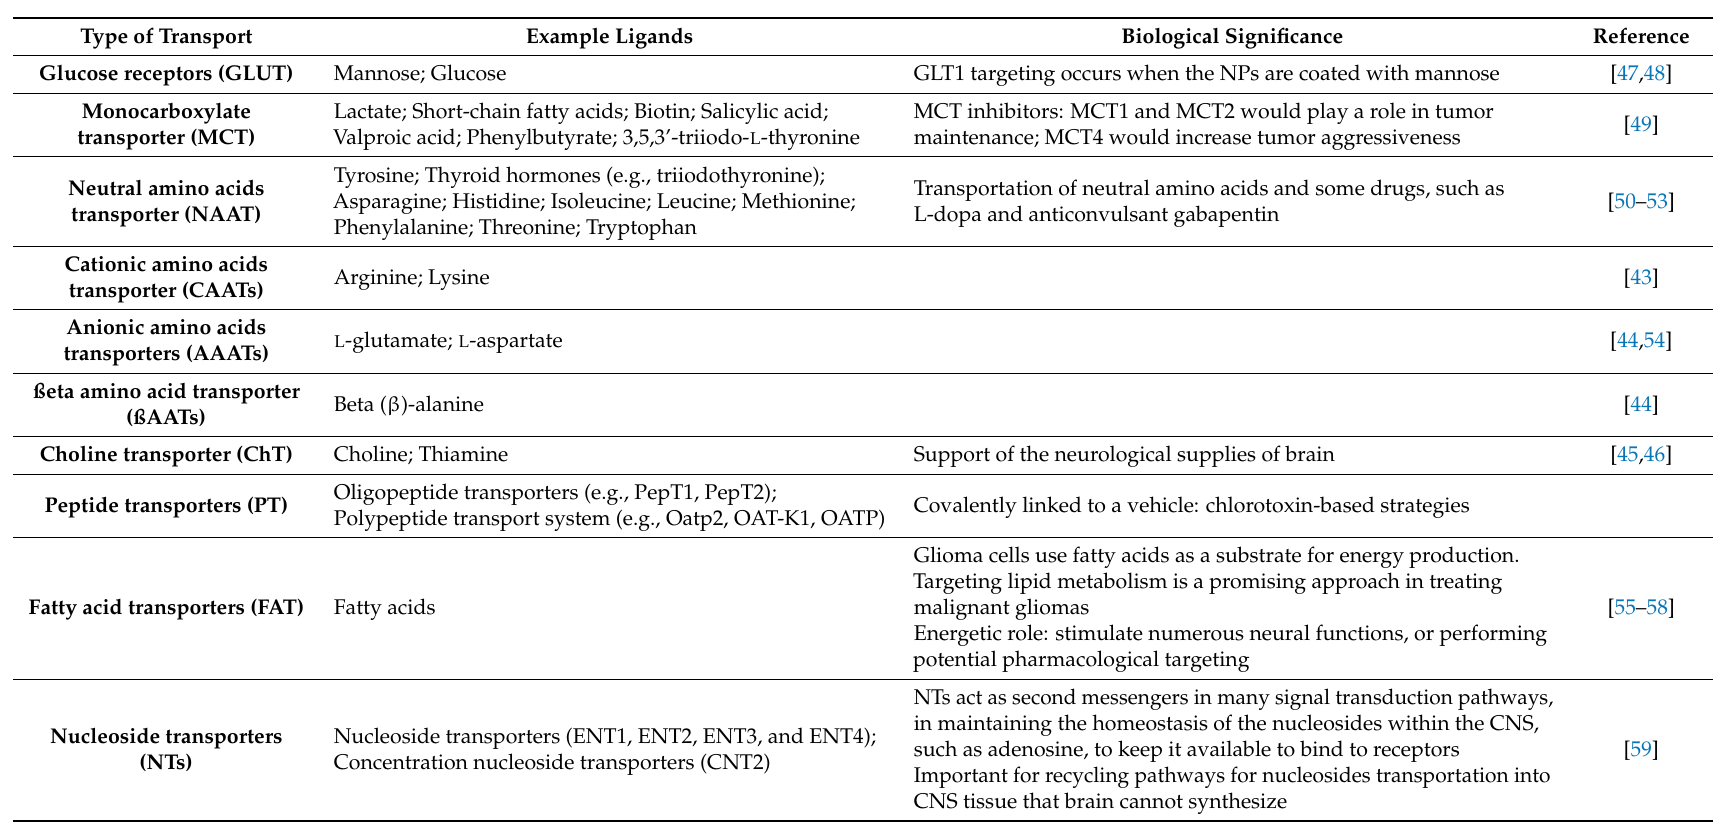
Table 2. Specific transporters expressed on